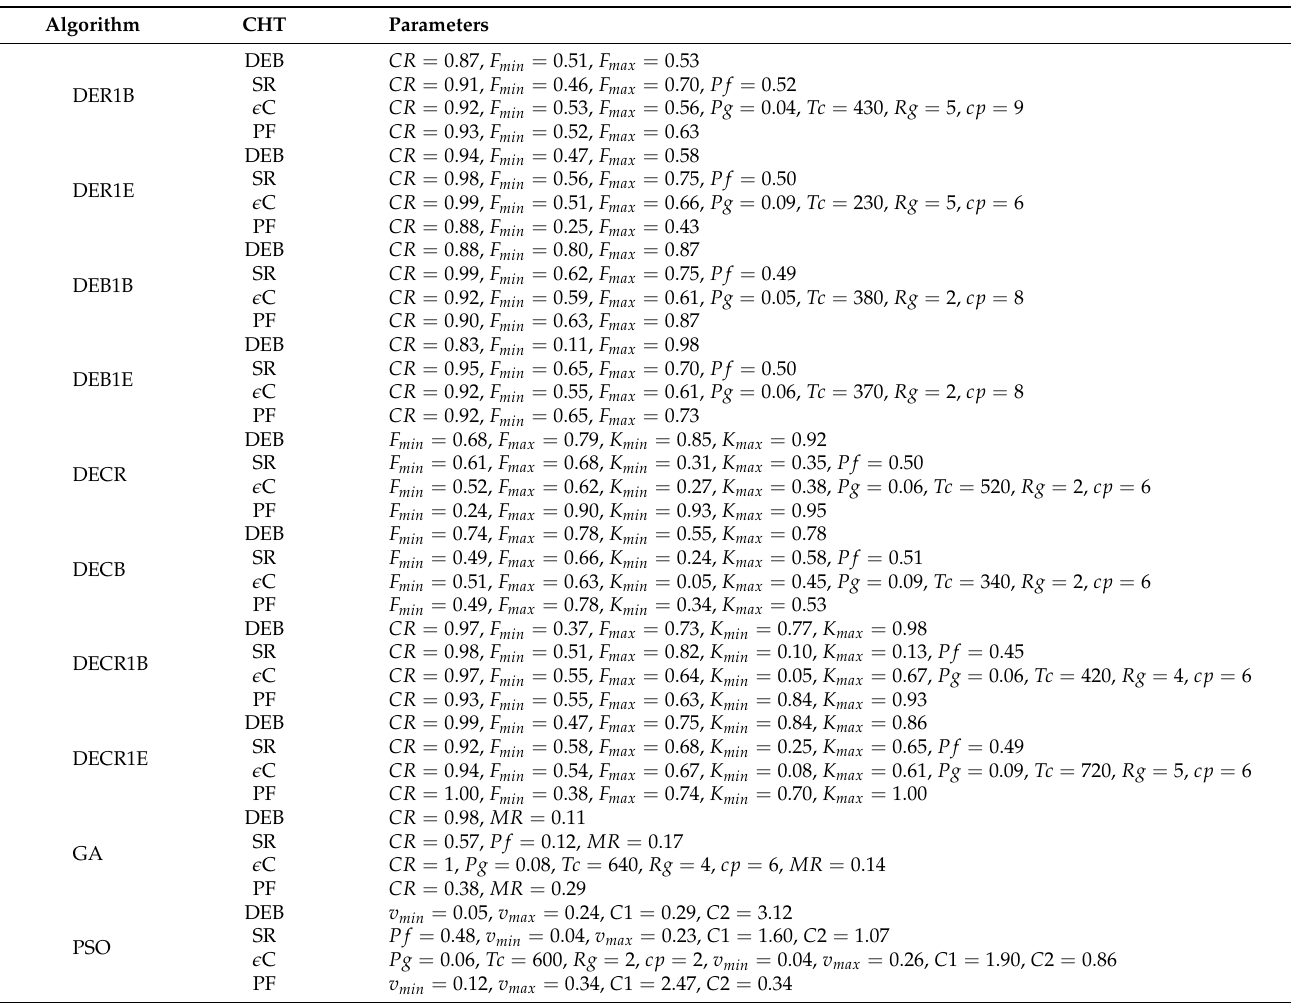
Table A5. Tuned parameters by irace program for the study case 2: Cam-linkage mechanism.